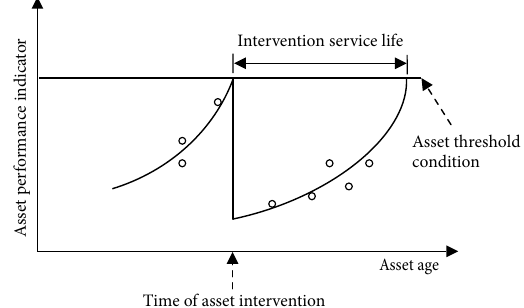
Fig. 4. Schematic representation of intervention service